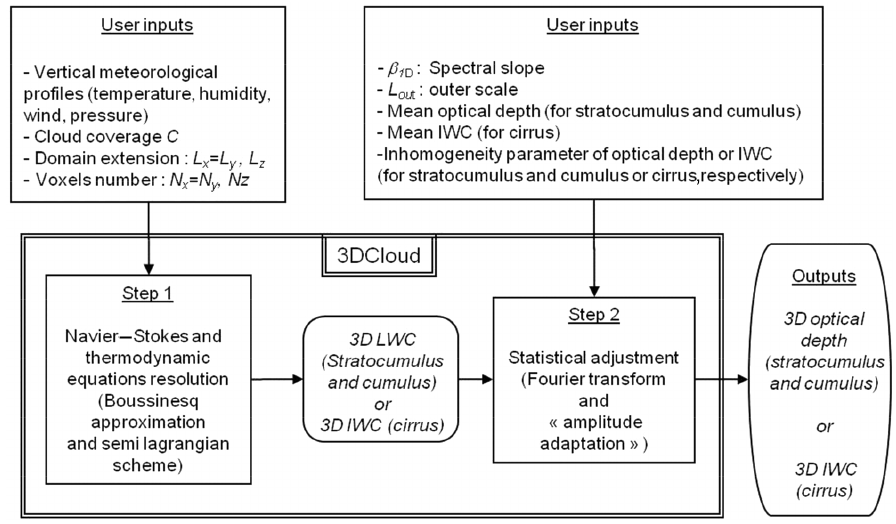
Figure 1. General flow chart of the stratocumulus, cumulus and cirrus generator 3DCloud. Note that 3DCloud algorithm is divided in two distinct